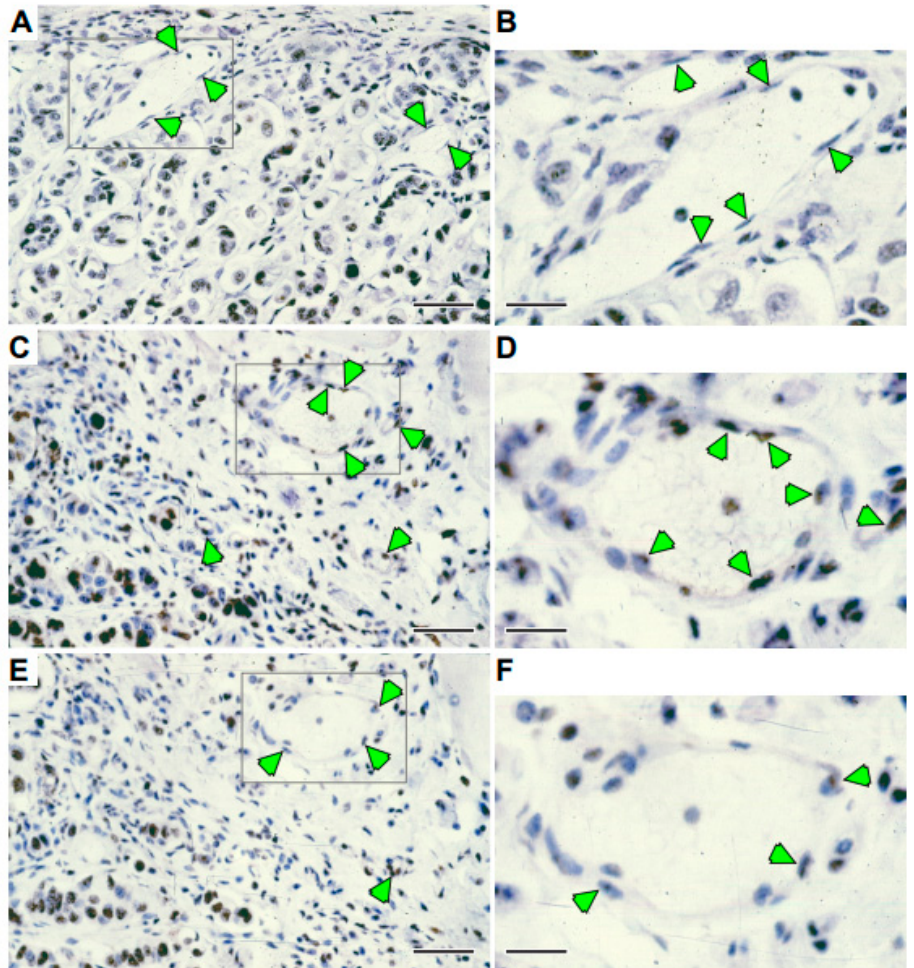
Figure 6. Ad sflt -mediated gene transfer induces tumor vascular endothelial cell apoptosis. Histologic sections from control and Ad sflt tumors were tested by the TUNEL method to visualize apoptotic cells. Control Ad virus-injected tumors did not exhibit apoptotic reactions in endothelial cells (arrowheads) ( A , B ) at any time point; while apoptic reaction, indicated by brown nuclear staining, is visible in Ad sflt -injected tumor serial sections ( C – F ) 7 days after treatment. Note that apoptotic endothelial cells appear round and loosely attached to the basement membrane (arrowheads). Left-hand panels ( A , C , E ) are the same magnification: the bar at the lower right of each is 10 mm. Gray boxes indicate inset areas shown in right-hand panels ( B , D , F ) increased in magnification by 2.5×; the bar at the lower left of each is 4 mm.